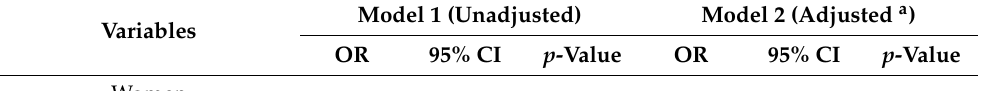
Table 4. Multivariate-adjusted ORs for abdominal obesity in relation to quartiles of health-related physical fitness measurements after adjustment for potential